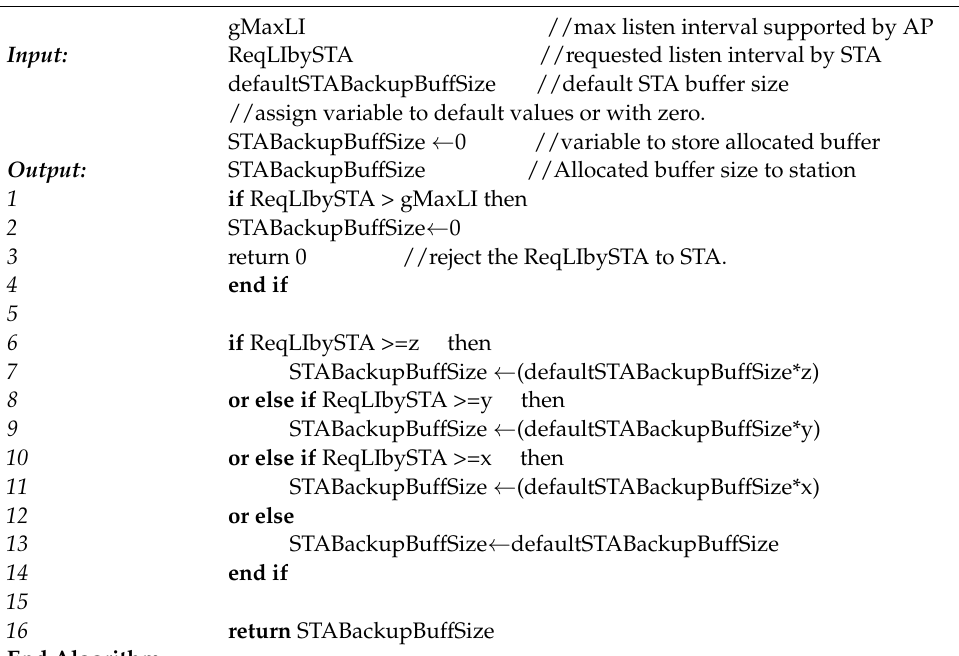
Algorithm 2: AP Dynamic Buffer